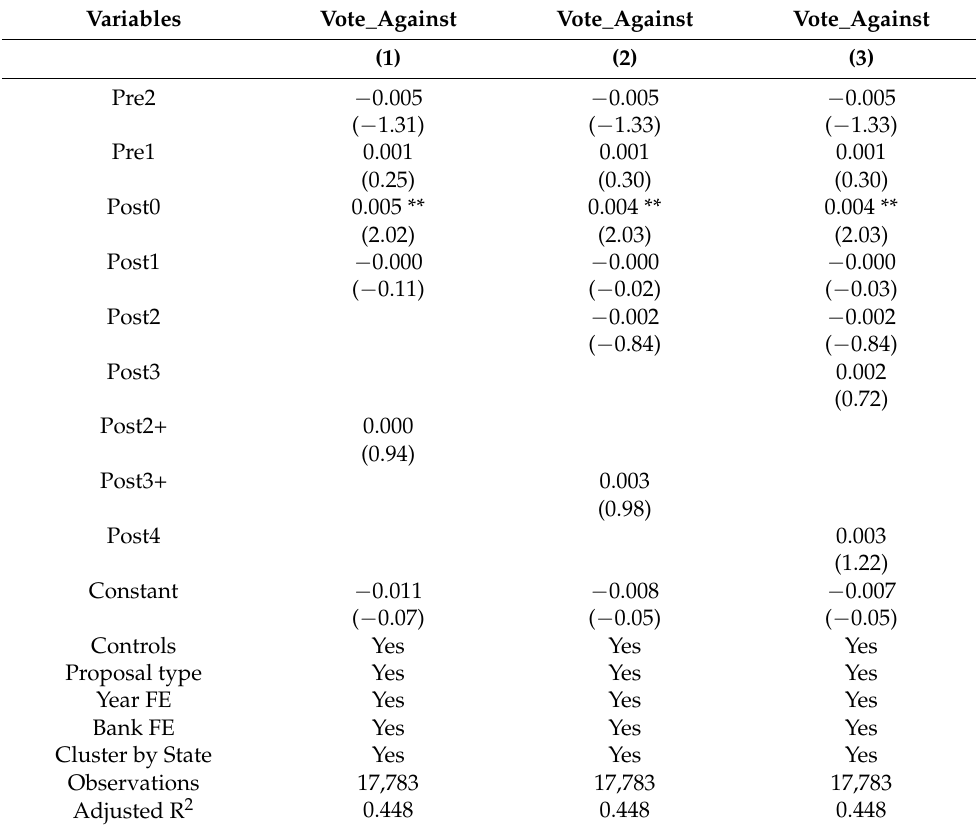
Table 8. Year dynamic